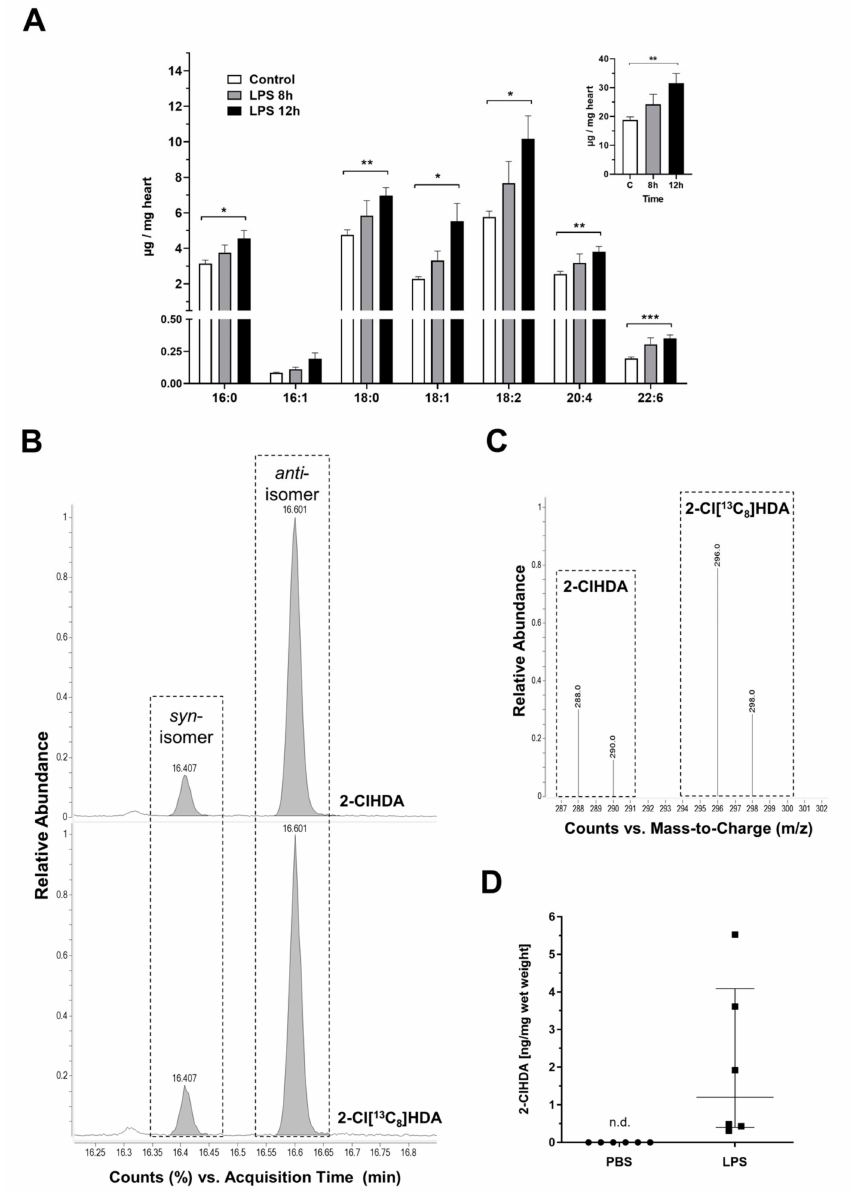
Figure 2. Accumulation of various fatty acid (FA) species and 2-ClHDA in LPS-treated hearts. C57BL / 6 mice received a single i.p. injection of PBS (200 µ ) or LPS in PBS (from Escherichia coli , 0111:B4 in PBS, 8 µ g / g body weight) and were sacrificed 8 or 12 h after the injection. ( A ) Cardiac FA composition of PBS- and LPS-injected mice was analyzed by gas chromatography. Inset shows total FA concentrations. Data represent mean + SEM; * p ≤ 0.05; ** p ≤ 0.01; *** p ≤ 0.001; unpaired student’s t -test ( n = 5–6). ( B – D ) Cardiac 2-ClHDA concentrations were quantified by selected ion monitoring (SIM) NICI–GC–MS analysis using 2-Cl[ 13 C 8 ]HDA as internal standard. ( B ) SIM chromatograms of a representative cardiac lipid sample (top; 12 h post LPS treatment) and the synthetic standard (bottom). Boxed areas indicate the elution profiles of the syn- and anti-PFB-oxime derivatives of 2-ClHDA and 2-Cl[ 13 C 8 ]HDA. ( C ) Fragment ion intensity ratios of 2-ClHDA ( m / z = 288, 290) and the internal standard ( m / z = 296, 298) of the peaks highlighted in ( B ). ( D ) Formation of 2-ClHDA in the hearts of LPS-treated animals ( n = 6) measured 12 h after a single systemic LPS injection. Lines represent median with interquartile range, unpaired student‘s t -test, non-detectable